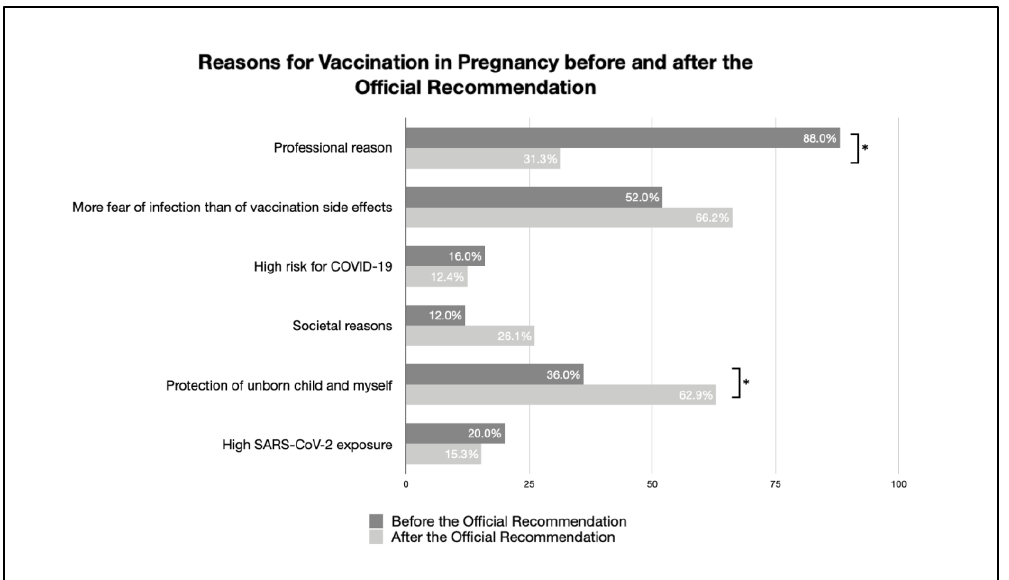
Figure 3. Reasons for vaccination in pregnancy before and after the official recommendation (per- centage of reasons given by participants for being vaccinated; multiple answers possible; * indicates a significant difference).